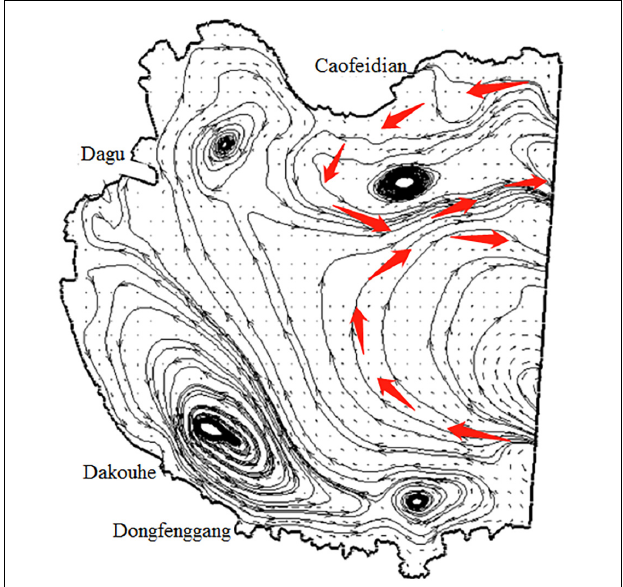
FIGURE 5 | Tide-induced Euler residual current in Bohai Bay.